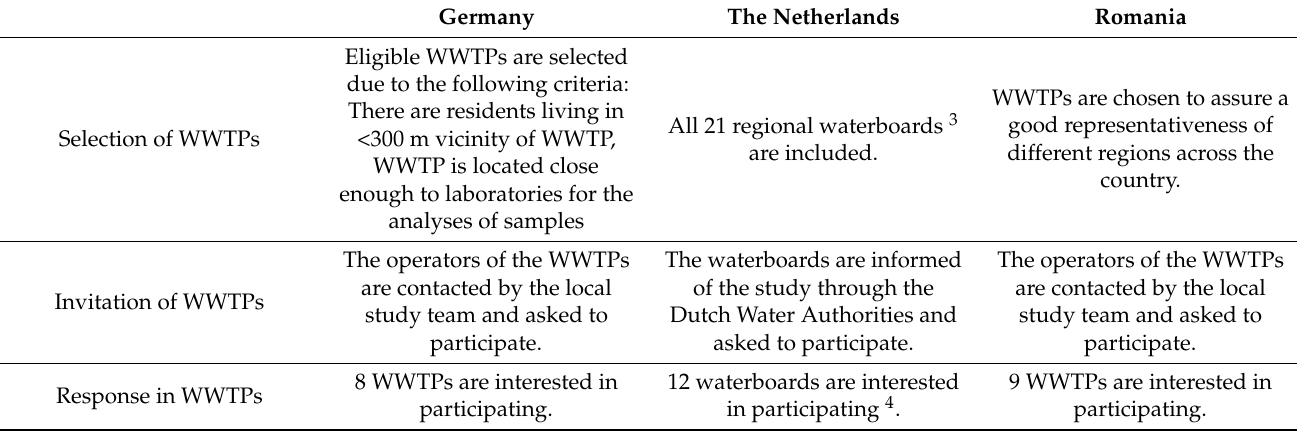
Figure 1. Legend Graphical Abstract: Overview of AWARE study, with ( A ) the participating coun- tries, ( B ) the study domain, wastewater treatment plant samples, and workers of and residents living nearby wastewater treatment plants, ( C ) the techniques involved (questionnaire, molecular and cultural analyses of ESBL-EC, CPE, and the resistome, and ( D ) the outcome: epidemiological evaluation of differences in prevalence of ESBL-EC, CPE, and the resistome between workers and residents of wastewater treatment plants and the general population, changes in relative and absolute resistance along different wastewater chains, and models for airborne and waterborne exposure to resistant bacteria and resistance genes. Table 1. Recruitment of participants into the AWARE